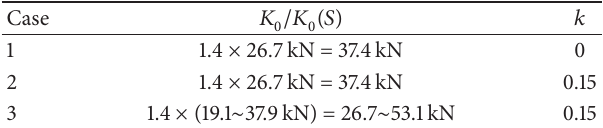
Table 3: The calculation